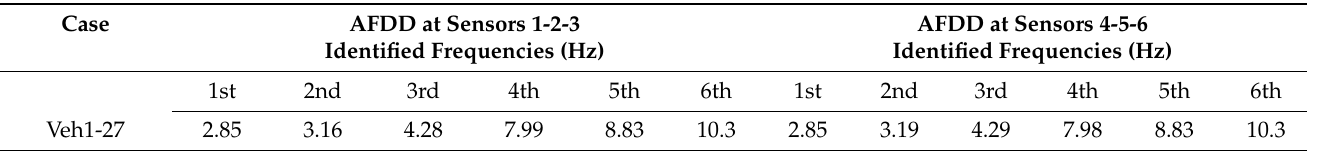
Table 17. Identified frequencies of numerical results with FDD method in the transverse direction (Offset Lane).